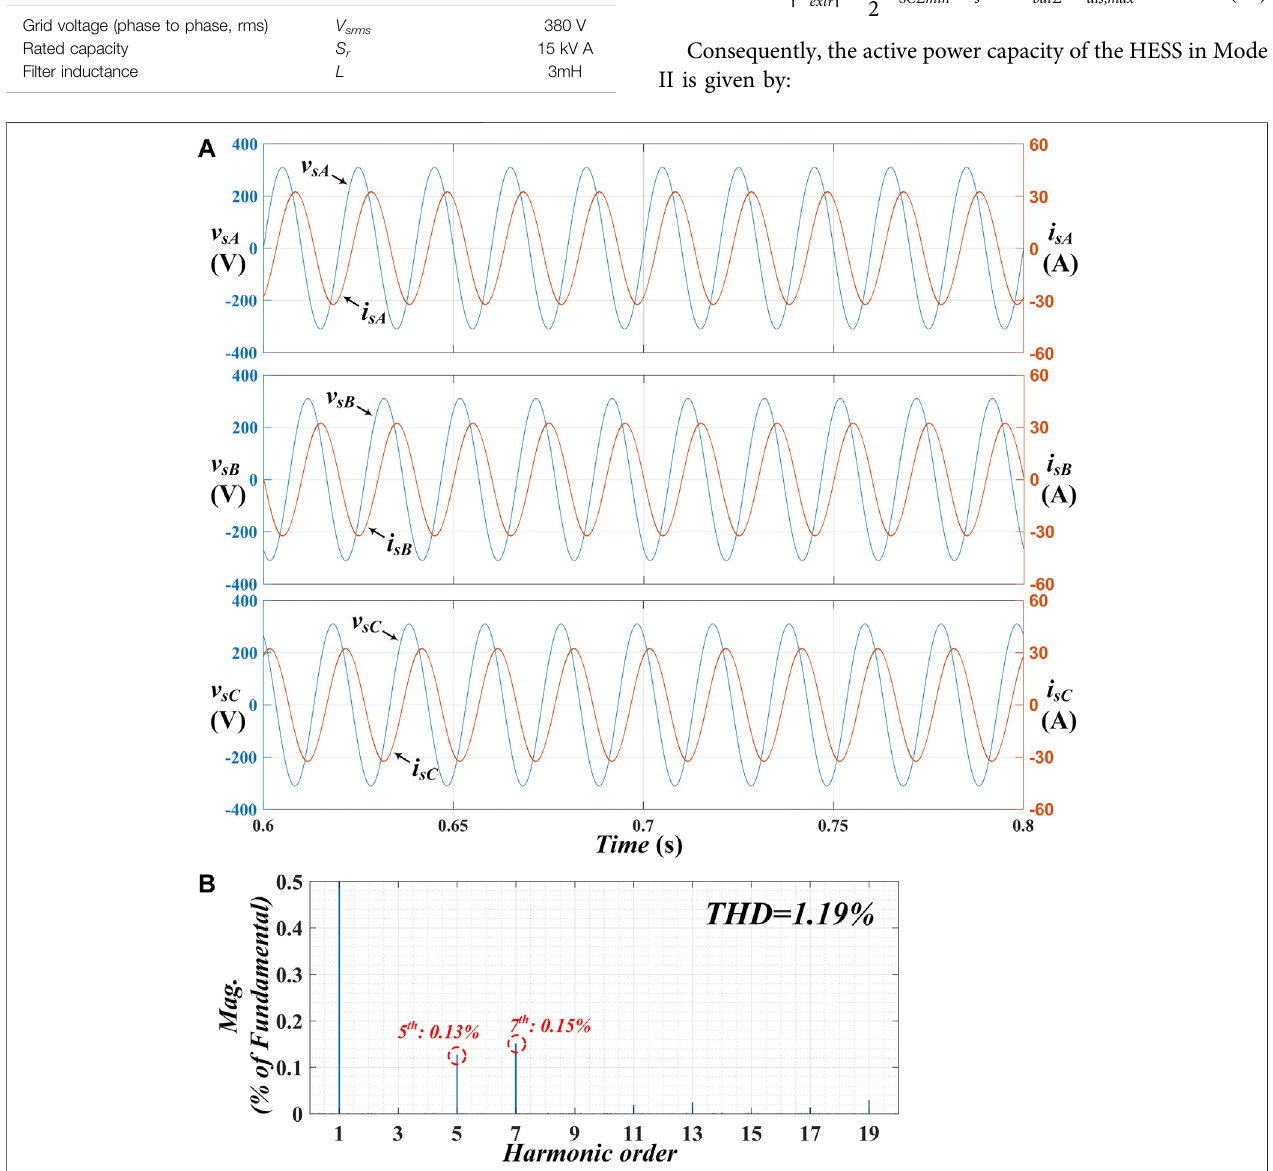
FIGURE 9 | Simulation results of grid voltage and output current; (A) Three phase grid voltage and output current waveforms; (B) Frequency spectrum analysis of i sA (cut out at